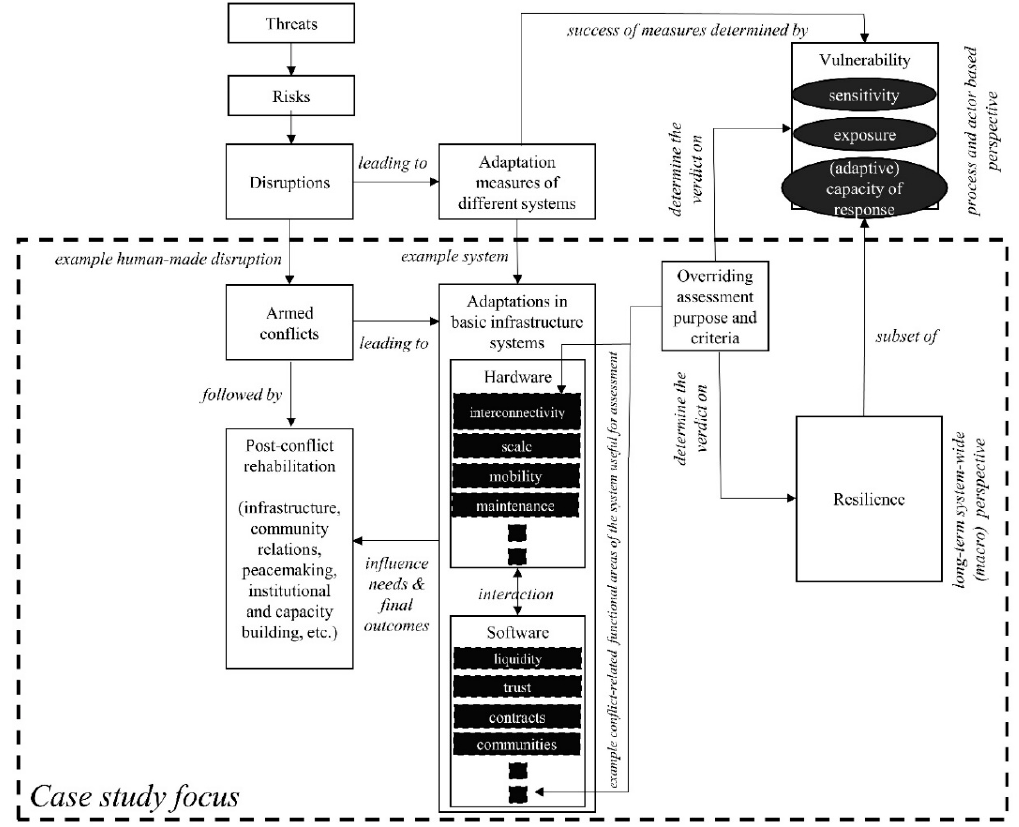
Figure 1. Conceptual framework and study outline.